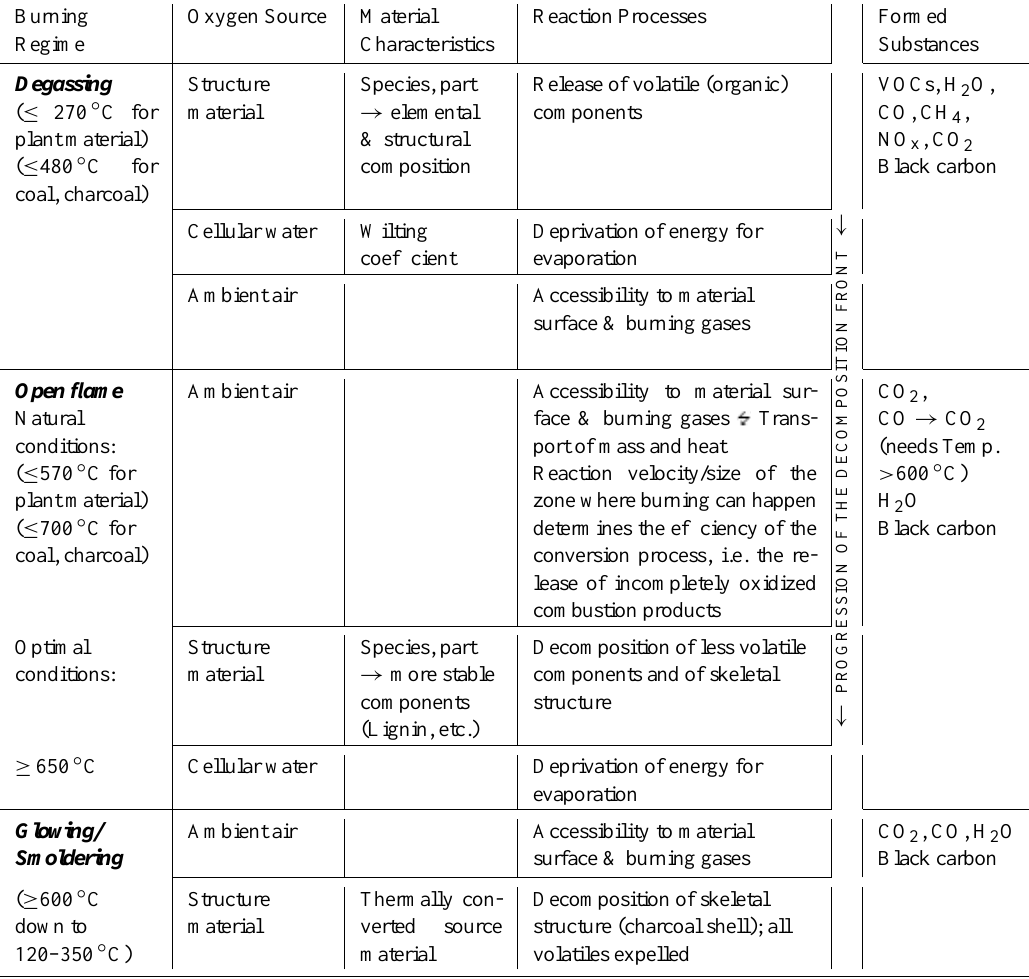
Table 1. General schematics of the burning regimes, the oxygen sources, material characteristics, the relevant combustion processes and of the formed substances. Depending on the kind of material, the environmental conditions and the burning behaviour the contribution of oxygen from the different sources and the formed products are variable.